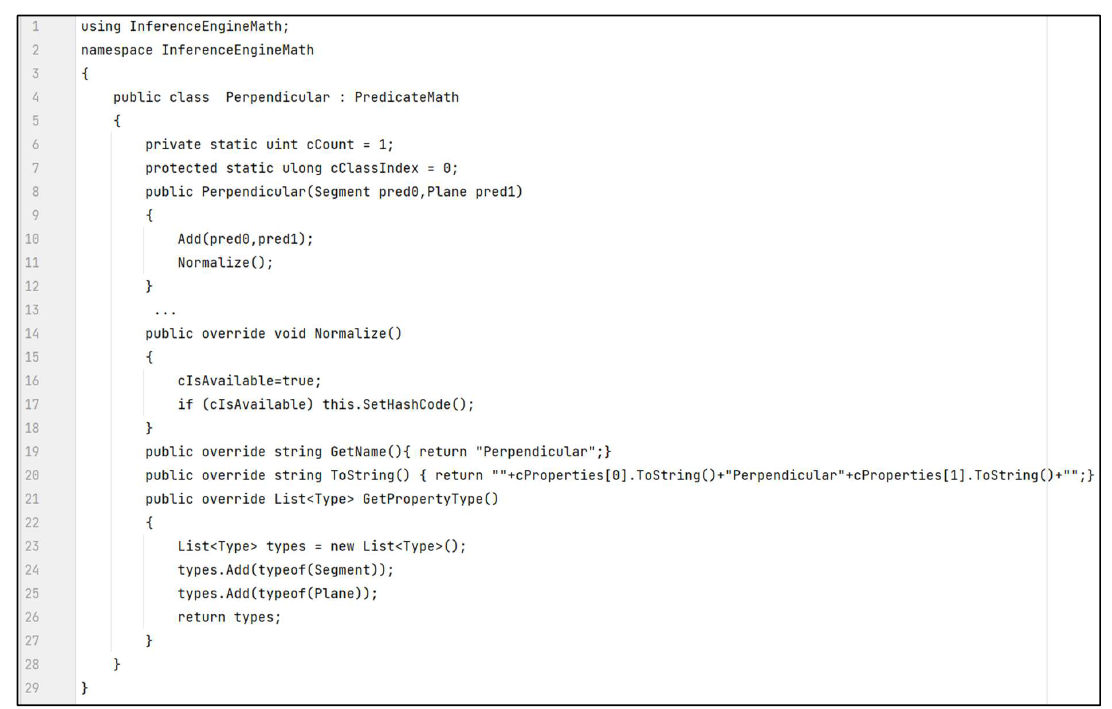
Figure 3. Predicate knowledge